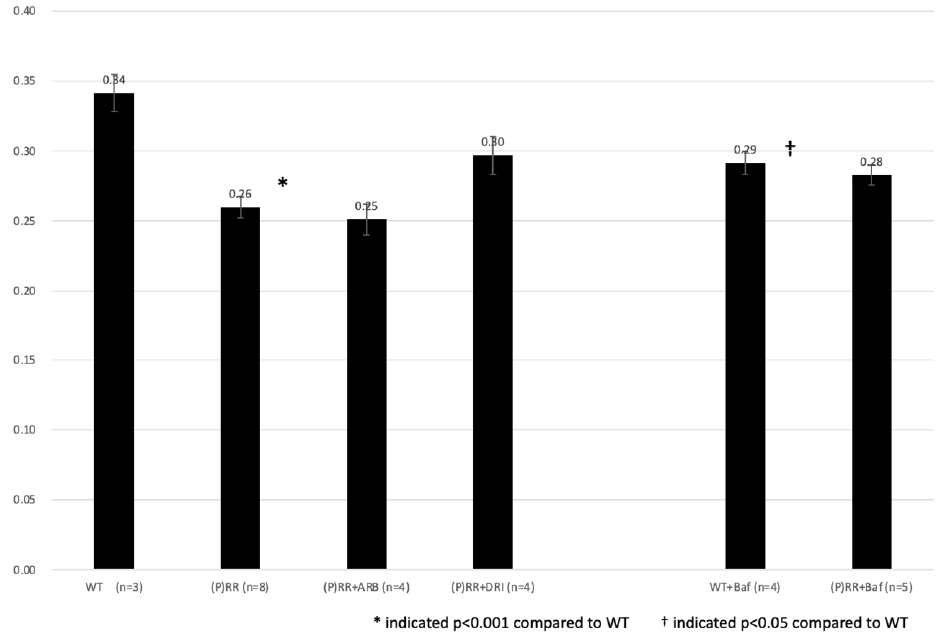
Figure 6. Average water intake (g/BW day) of animals were shown. Data were analyzed using one-way ANOVA between (P)RR mice and t -test between WT and (P)RR mice.